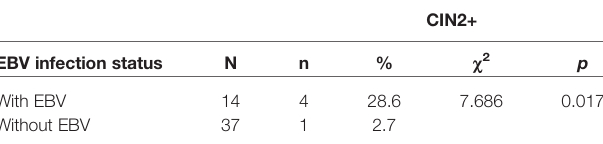
TABLE 3 | Distribution of CIN2+ in HPV- and HIV-positive women with or without EBV.